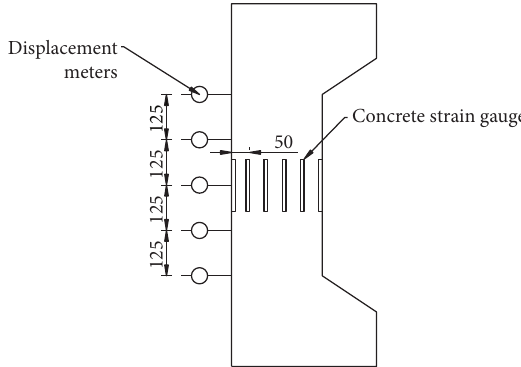
Figure 3: Distribution of the strain gauge (mm).